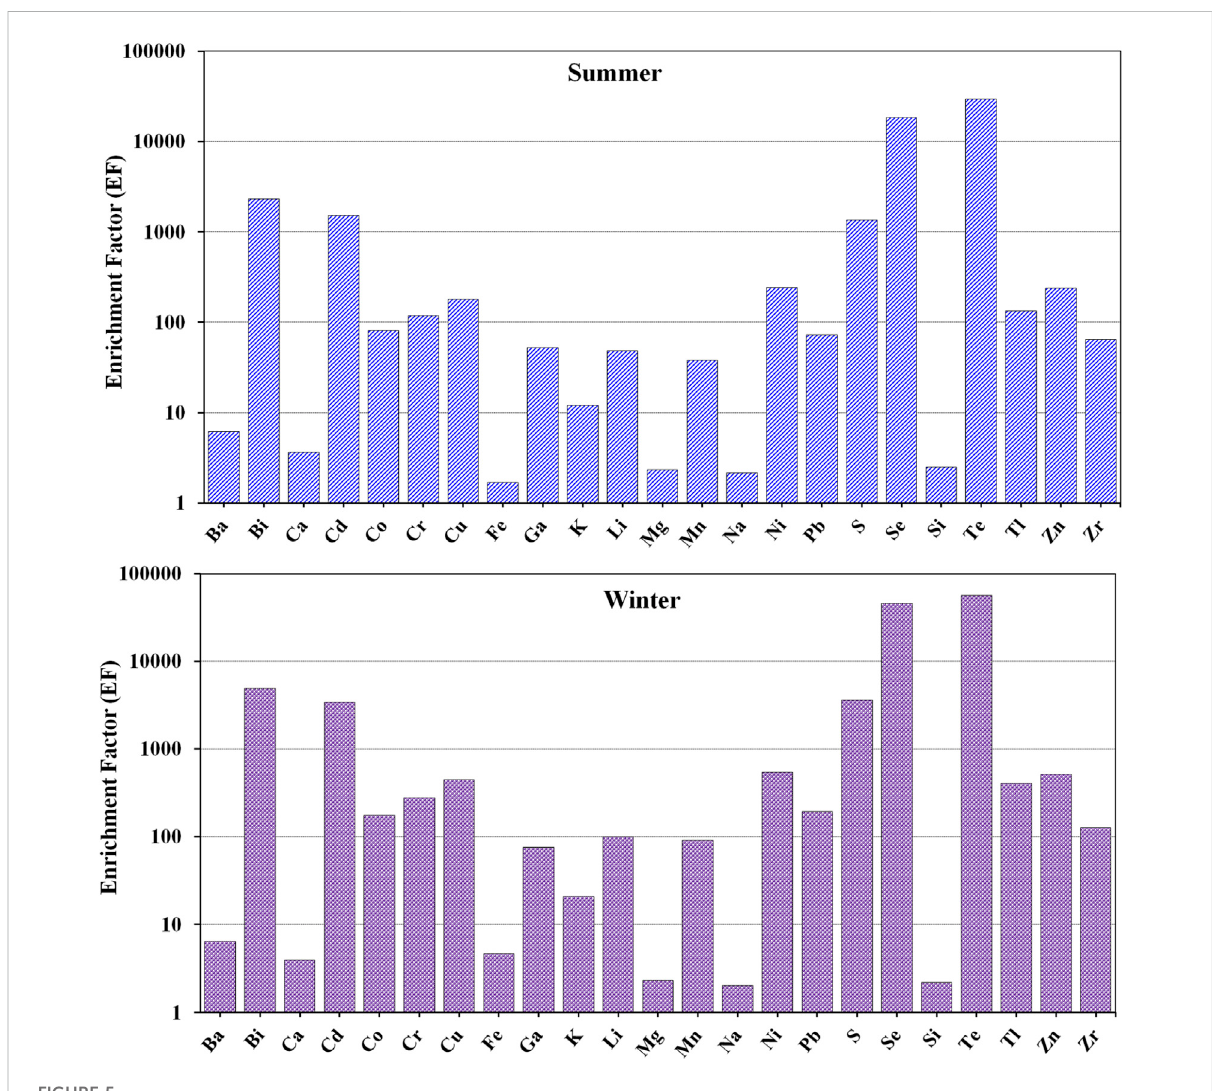
FIGURE 5 Estimated values of enrichment factor (EF) of individual elements during summer and